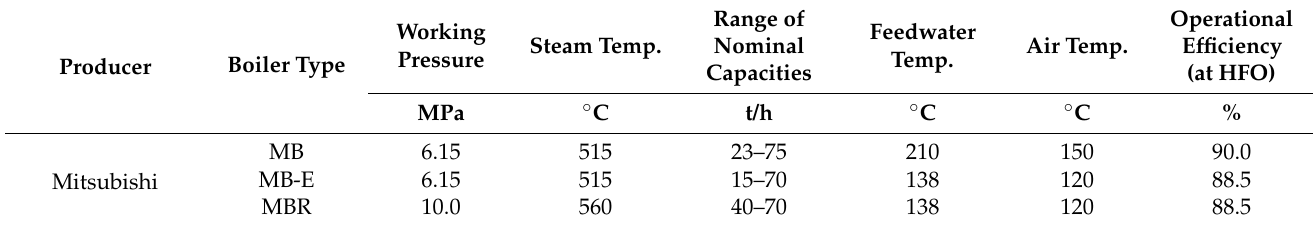
Table 1. Comparison of the method of utilizing exhaust gas waste heat from the